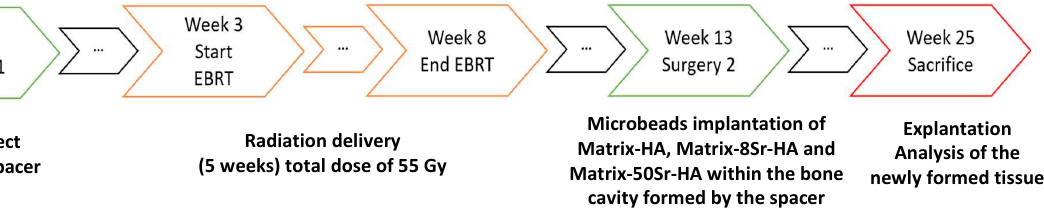
Figure 1. Radiation and matrices implantation procedure: the different steps of the two surgeries according to Masquelet method and the radiation delivery procedure are summarized in this scheme. EBRT: External Beam RadioTherapy.